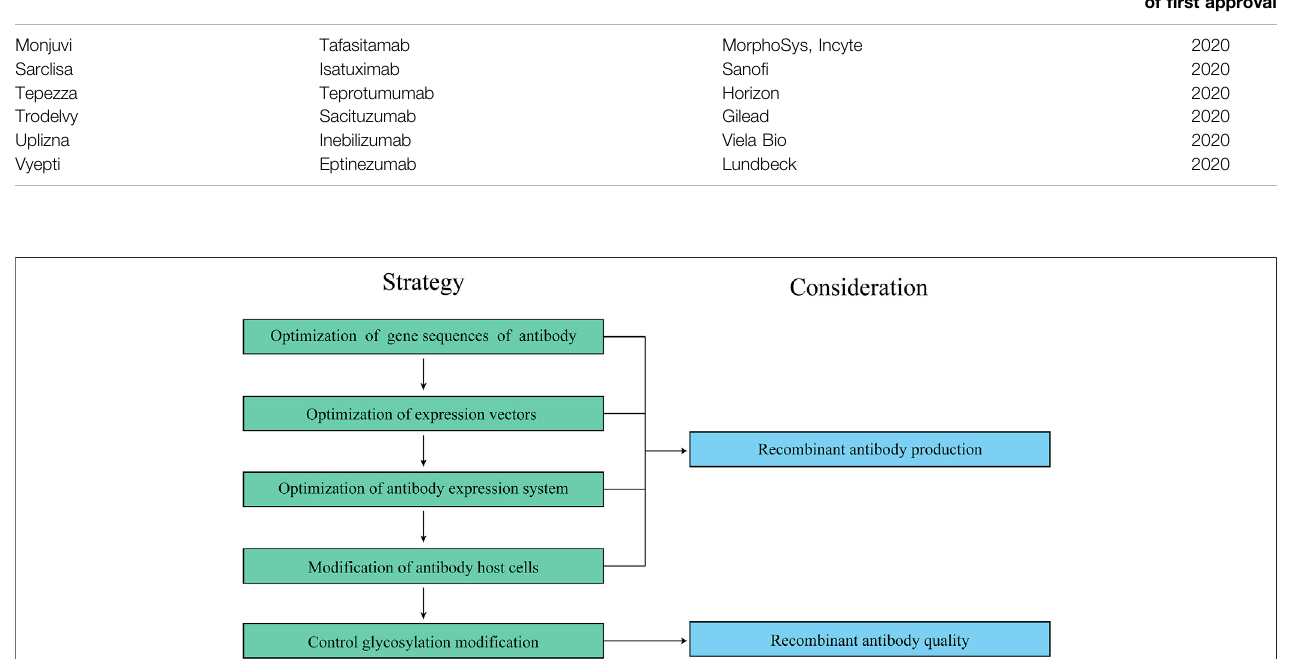
FIGURE 2 | A work fl ow for optimizing recombinant antibody production and quality in CHO cells. Too many factors can impact recombinant antibody production and quality in CHO cells, therefore, it is important to follow a speci fi c work fl ow when dealing with recombinant antibody production and quality.